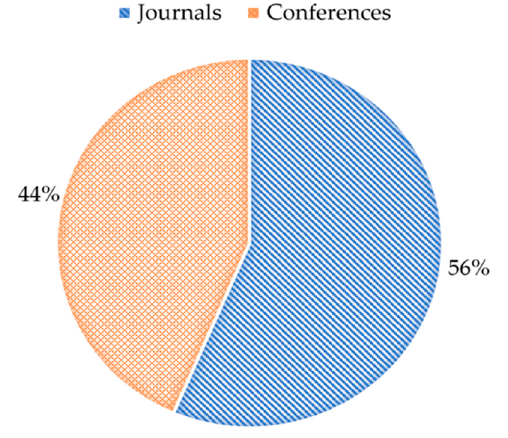
Figure 3. Types of articles reviewed.